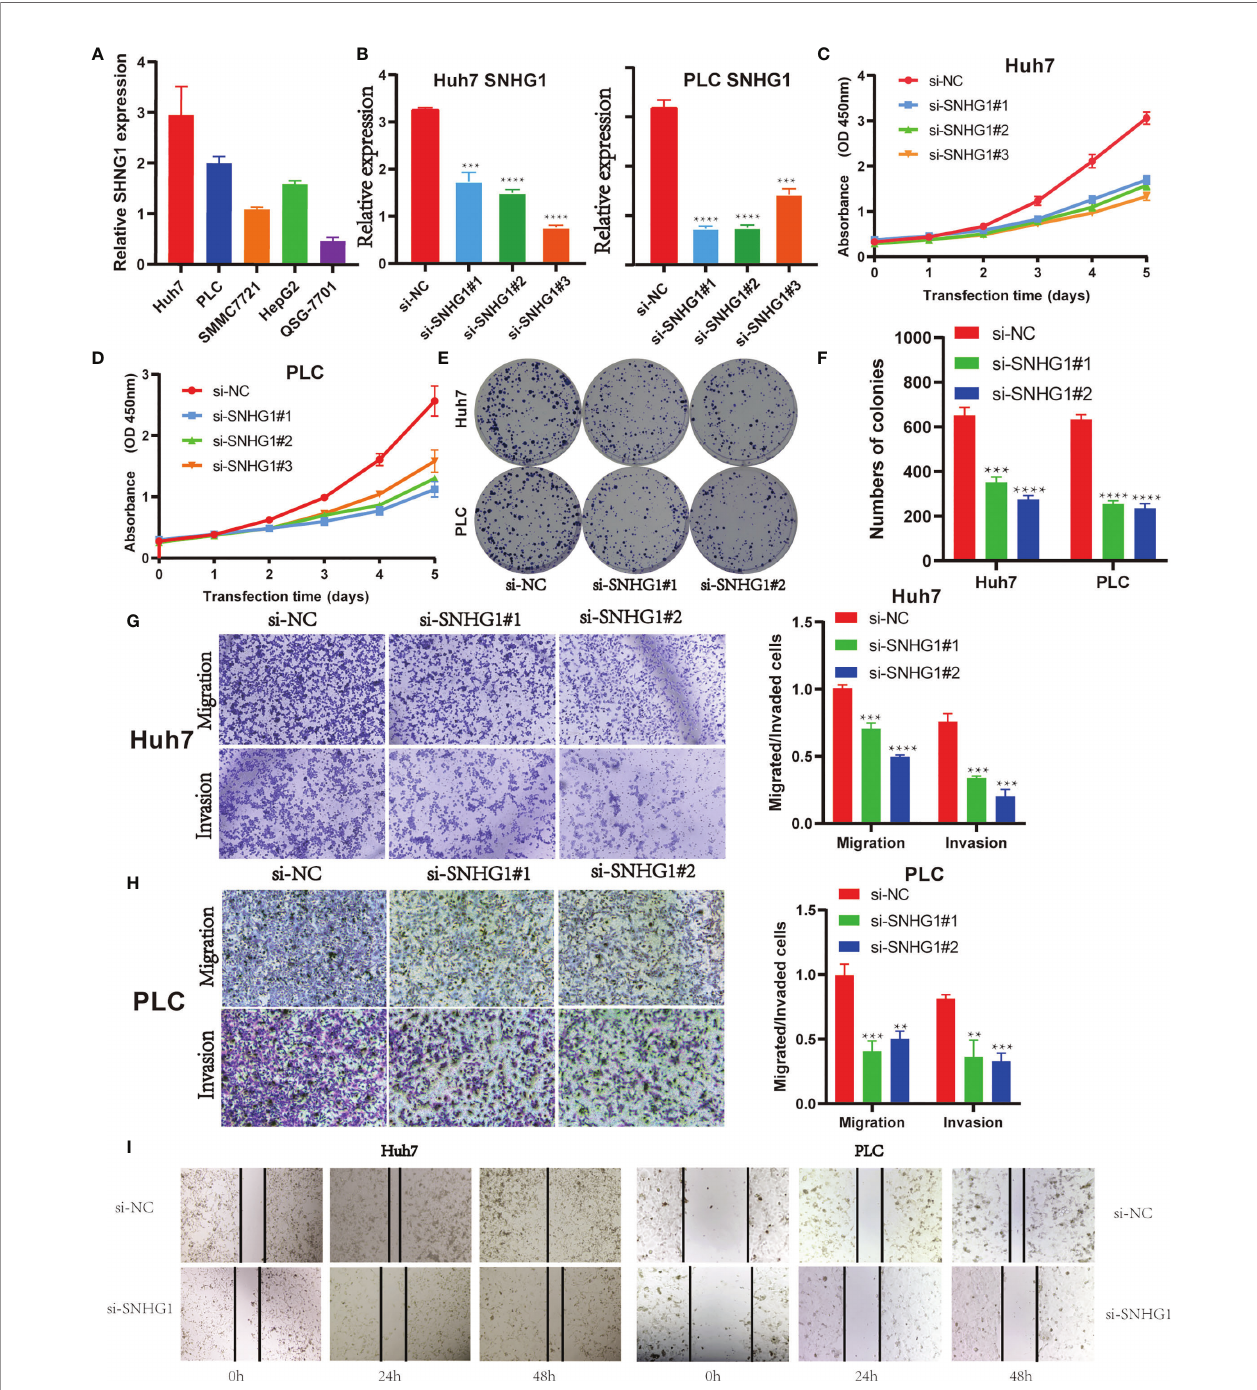
FIGURE 5 | SNHG1 promotes proliferation, migration, and invasion of hepatocellular cancer cells. (A) Relative expression of SNHG1 was detected in QSG-7701 and the other four hepatocellular carcinoma (HCC) cell lines by RT-qPCR. (B) Expression of SNHG1 in Huh7 and PLC cells with SNHG1 knockdown detected by RT-qPCR (***p < 0.001, ****p < 0.0001). (C) Optical density (OD) value of Huh7 cells with SNHG1 knockdown and control cells in 3-(4,5-Dimethylthiazol-2-yl)-2,5- diphenyltetrazolium bromide (MTT) assay. (D) OD value of PLC cells with SNHG1 knockdown and control cells in MTT assay. (E) Colonies of Huh7 and PLC cells with SNHG1 knockdown and control cells in the colony formation assay. (F) The number of colonies was calculated 14 days after cell seeding (***p < 0.001, ****p < 0.0001). (G) Migratory and invasive potential of Huh7 cells with SNHG1 knockdown and control cells (***p < 0.001, ****p < 0.0001). (H) Migratory and invasive potential of PLC cells with SNHG1 knockdown and control cells (**p < 0.01, ***p < 0.001). (I) Wound healing assay was used to detect the migratory ability of Huh7 and PLC cells with SNHG1